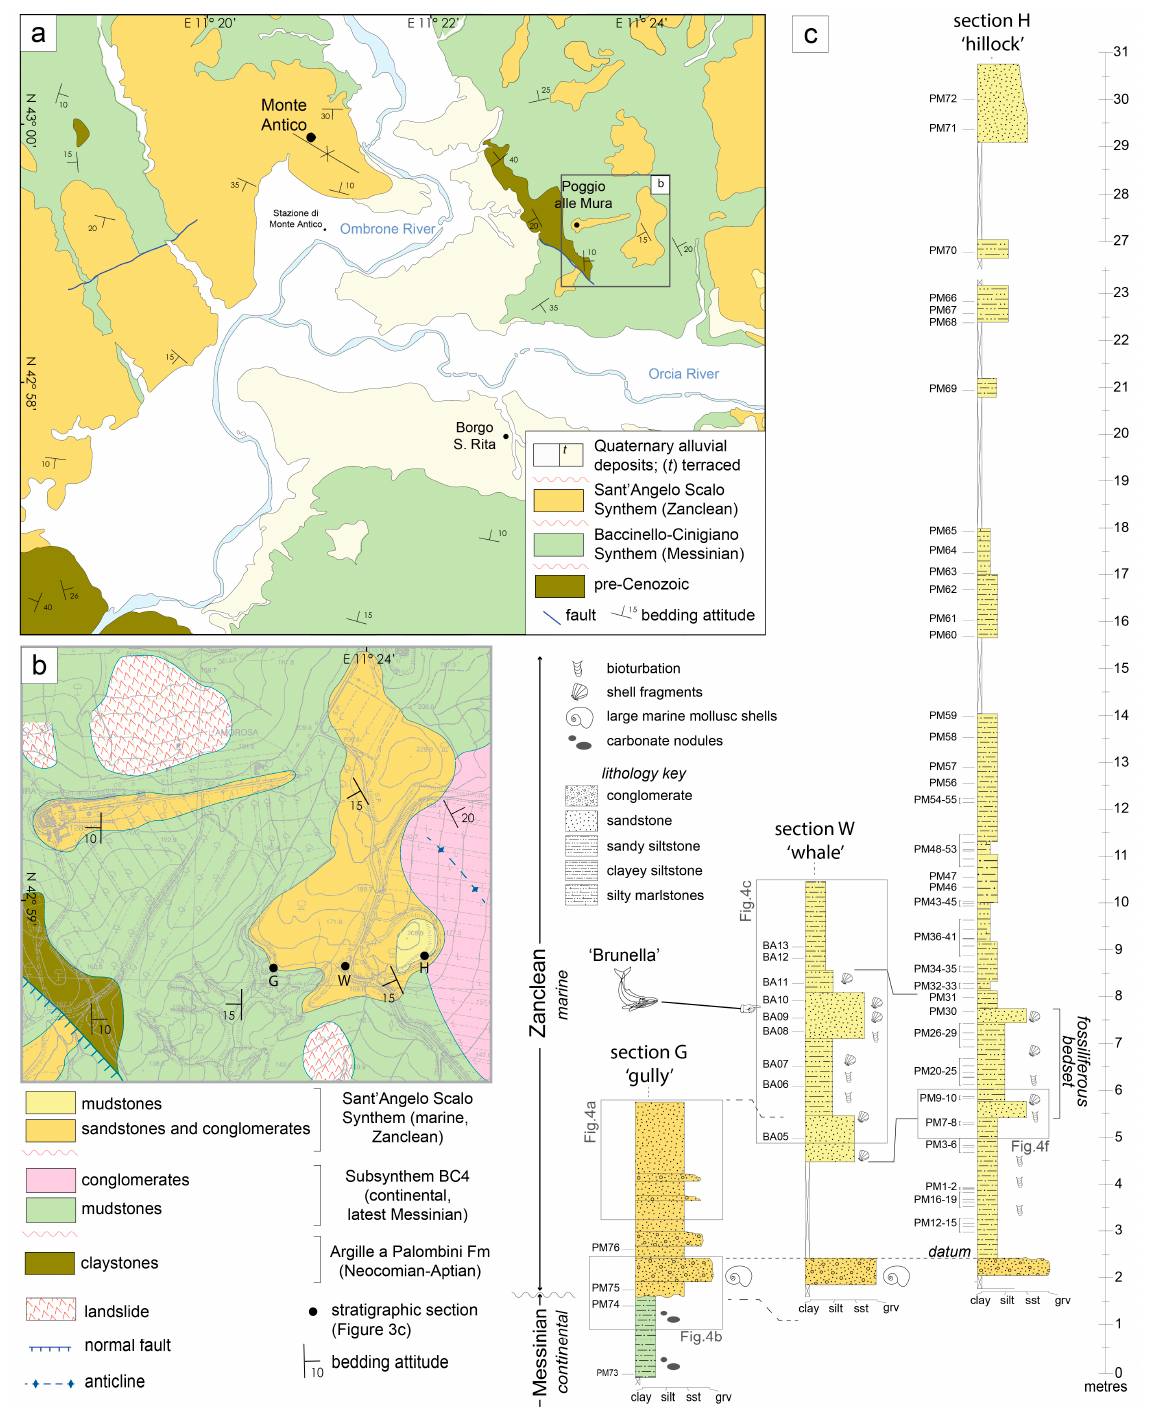
Figure 3. ( a ) Simplified geological map and ( b ) detail of the study area (modified, after [20] and [32]) with location of the sections making the Brunella composite section; ( c ) stratigraphic log of the Brunella composite section with positions of samples. Section G ’gully’ (Figure